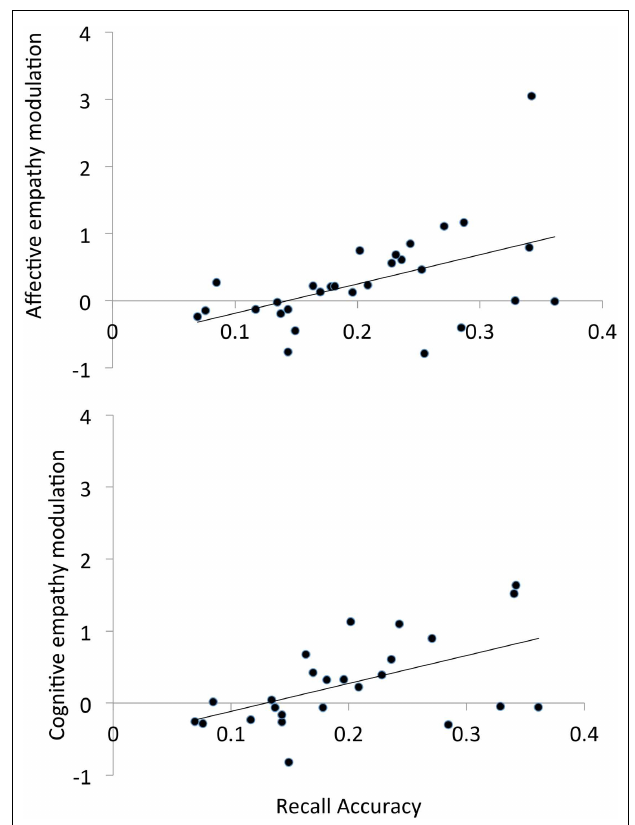
FIGURE 2 | Scatter plot of the bivariate correlation between recall accuracy for the life-stories and the affective empathy modulation index (TOP panel) and the cognitive empathy modulation index (BOTTOM